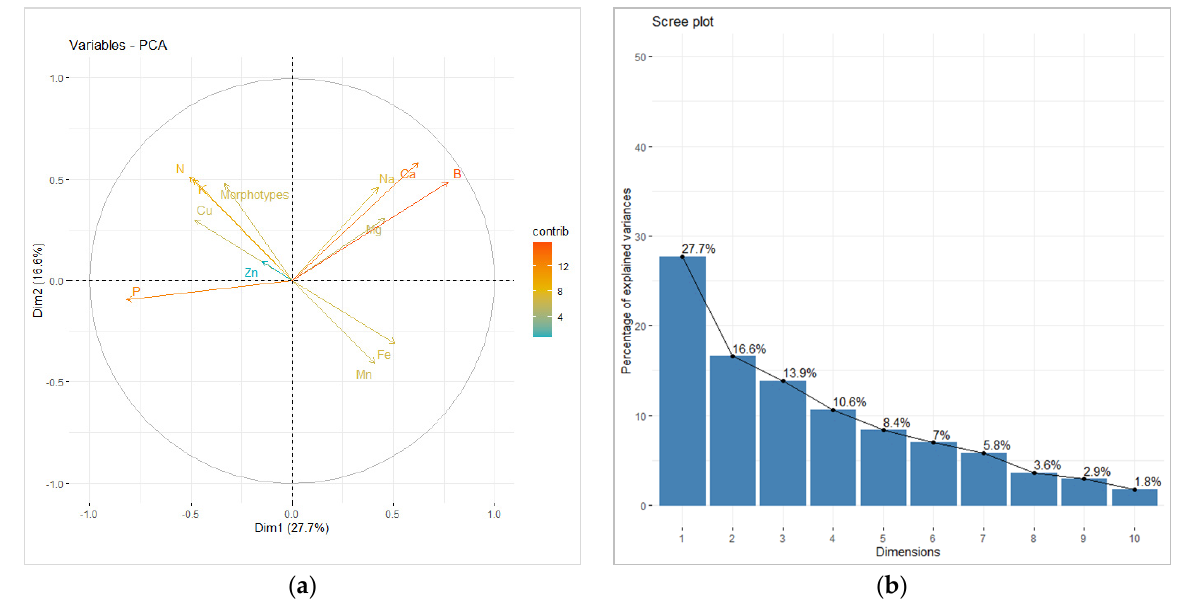
Figure 4. Principal component analysis (PCA) of ( a ) the studied macro- and micro-nutrients of tulips’ above-ground biomass (vectors), and ( b ) the respective contribution of each component to their total variability.